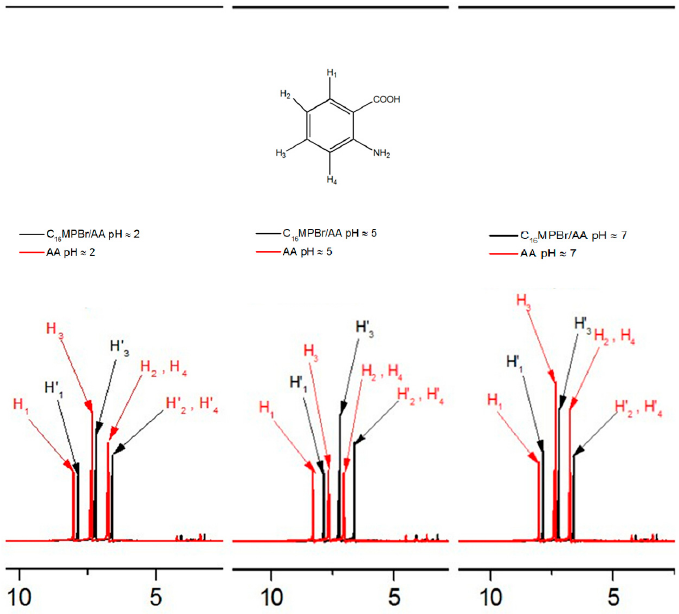
Figure 7. The 1 H-NMR spectrum of 80 mM AA in the presence and absence of 80 mM C 16 MPBr at different pH values.